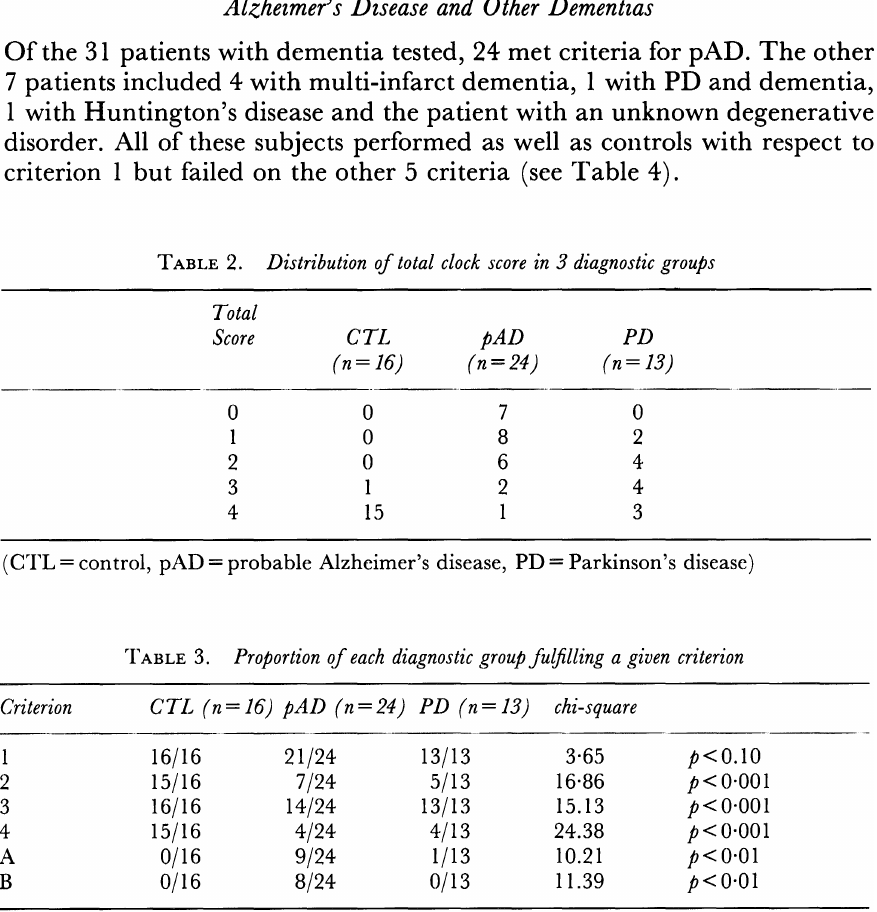
TABLE 3. Proportion of each diagnostic group fulfilling a given